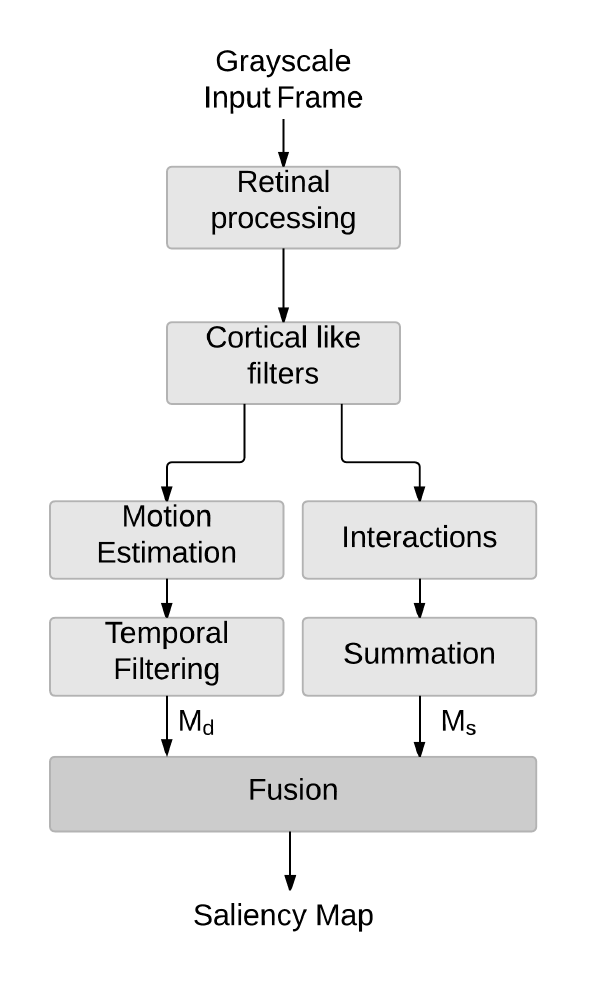
Figure 3 . The spatio-temporal saliency model: M d is the luminance-based dynamic map, M s is the luminance- based static map (Marat et al.,